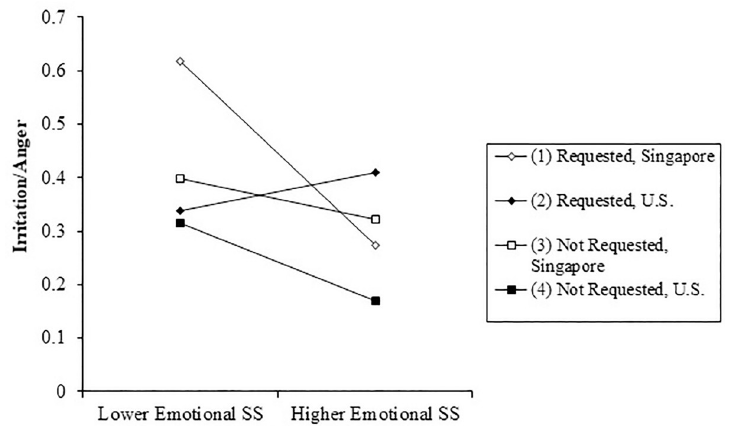
Fig 1. Interaction among culture, emotional SS provision, and solicitation of SS on